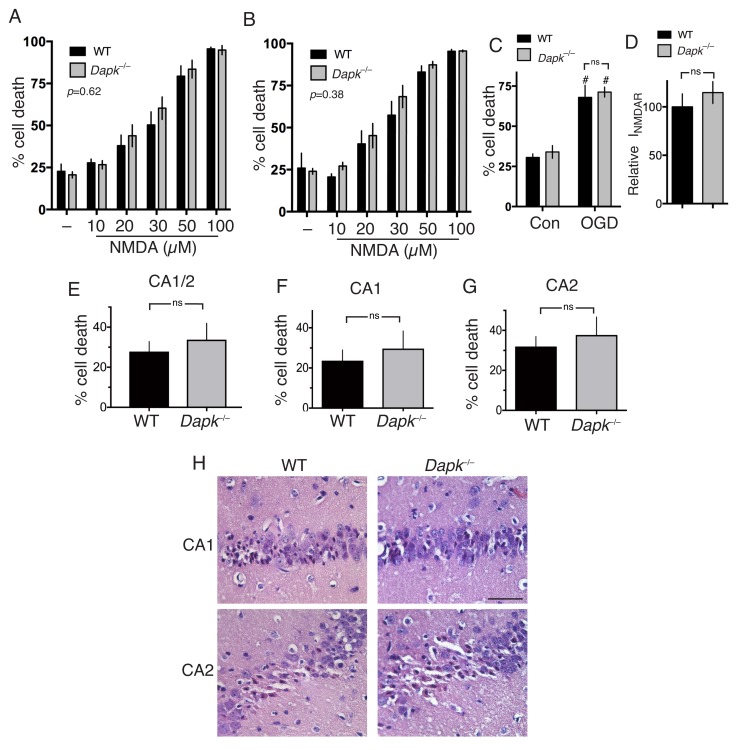
Excitotoxic and ischemic insults are not ameliorated by Dapk1 deficiency.(A, B) NMDA-induced neuronal death is independent of Dapk1. Cortical neurons at DIV10 (A) or DIV16 (B) were treated as indicated for 1 hr, with neuronal death assessed at 24 hr. The p values relate to a two-way ANOVA test of differences between WT and Dapk–/– neurons (F(1,10) = 0.2676, n = 6 WT, 6 KO (DIV10); F(1,7)=0.8871, 2-way ANOVA, n = 4 WT, 5 KO (DIV16)). For each condition/genotype combination, 800–1000 cells were analysed per biological replicate. (C) OGD-induced neuronal death is independent of Dapk1. Cortical neurons at DIV10 were subjected to OGD for 120 min, before being returned to control medium. Neuronal death was assessed at 24 hr. No genotype-dependent difference was observed (F (1,12)=0.5062, p=0.490, but a strong influence of OGD was observed: F (1,12)=63.54, p<0.0001, two-way ANOVA. #p=0.0002, 0.0002 (reading left to right); Sidak's post-hoc test comparing control to OGD condition (n = 4 WT, n = 4 KO). (D) Dapk1 deficiency does not influence NMDAR currents. NMDAR currents were measured in n = 16 WT cells (from four separate cultures) and n = 25 KO cells (from six separate cultures). Currents were normalized to the mean current recorded from WT cells recorded on that precise day. p=0.411 (t = 0.831, df = 39), unpaired t-test. (E–G) Dapk1 deficiency does not influence vulnerability to ischemia in vivo. Adult male age-matched mice (n = 14 WT; n = 16 KO) were subjected to 20 min bilateral common carotid artery occlusion, sacrificed at 3 d, and pathology analysed. CA1/2 (E): p=0.555 (t = 0.598, df = 28); CA1 (F) :p=0.572 (t = 0.572, df = 28), CA2 p=0.592(G, t = 0.543, df = 28). Scale bar = 50 µm.DOI:
http://dx.doi.org/10.7554/eLife.17161.01010.7554/eLife.17161.011Figure 2—source data 1.Data relating to Figure 2a.DOI:
http://dx.doi.org/10.7554/eLife.17161.01110.7554/eLife.17161.012Figure 2—source data 2.Data relating to Figure 2b.DOI:
http://dx.doi.org/10.7554/eLife.17161.01210.7554/eLife.17161.013Figure 2—source data 3.Data relating to Figure 2c.DOI:
http://dx.doi.org/10.7554/eLife.17161.01310.7554/eLife.17161.014Figure 2—source data 4.Data relating to Figure 2d.DOI:
http://dx.doi.org/10.7554/eLife.17161.01410.7554/eLife.17161.015Figure 2—source data 5.Data relating to Figure 2e–g.